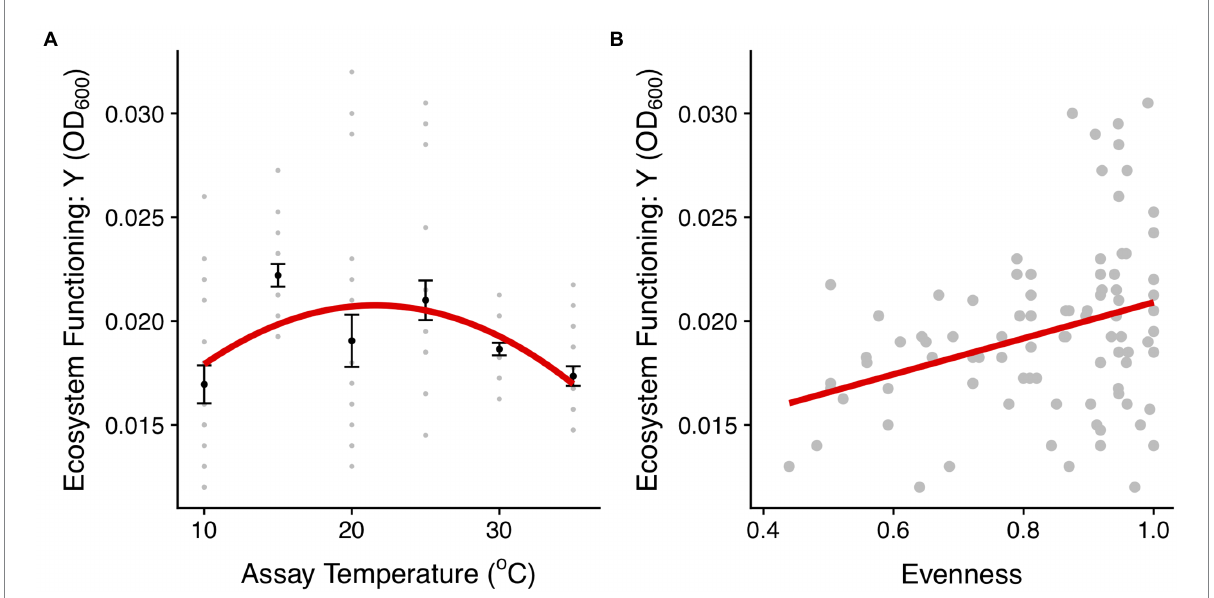
FIGURE 6 Linking community structure and ecosystem functioning. (A) Biomass production (OD 600 ) for communities in each temperature treatment. The red line represents the fit of a quadratic model (see details of model selection in Supplementary Table S7). The black dots and the error bars represent the mean across replicates for each temperature treatment and the SEM. The gray points are the different community replicates for each temperature treatment. (B) Relationship between the evenness in the abundance distribution and ecosystem functioning estimated using the asymptotic biomass (OD 600 ). The red lines represent the fit of a linear model ( p < 0.01, Supplementary Table